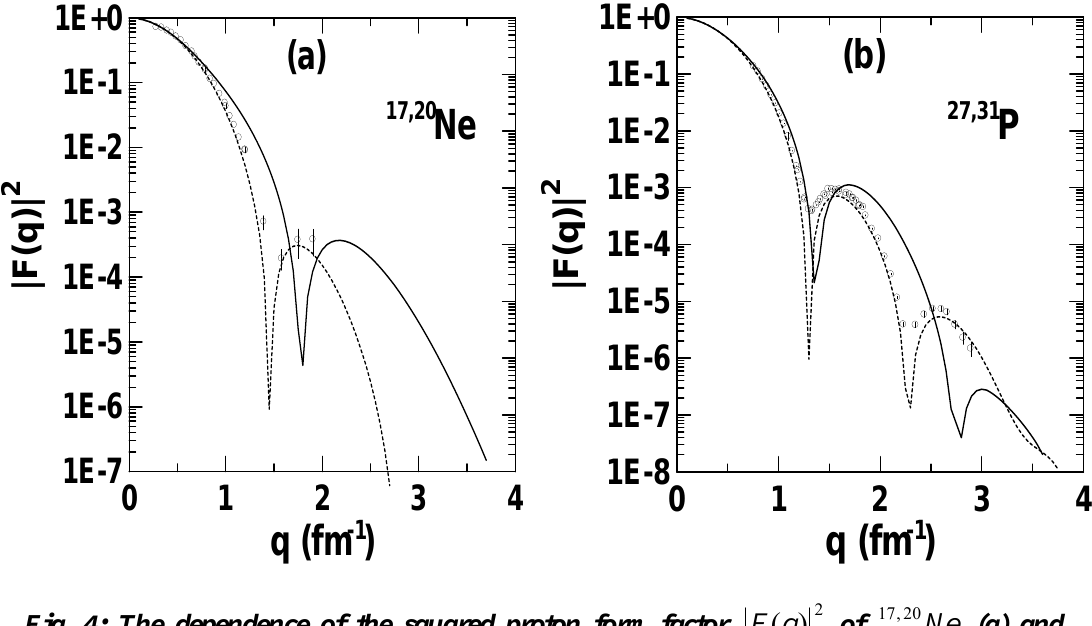
Fig. 4: The dependence of the squared proton form factor P 31,27 (b) on the momentum transfer q (in fm -1 ). Here, the input proton density distributions are those of Figs. 3(a) and 3(b), respectively. In (a) and (b), the solid lines are the squared proton form factors of unstable proton-rich Ne 17 and P 27 nuclei while the dashed lines are those of stable Ne 20 and P 31 nuclei. The open circles in (a) and (b) are the experimental charge form factors of Ne 20 and P 31 taken from Refs. [42] and [43], respectively.